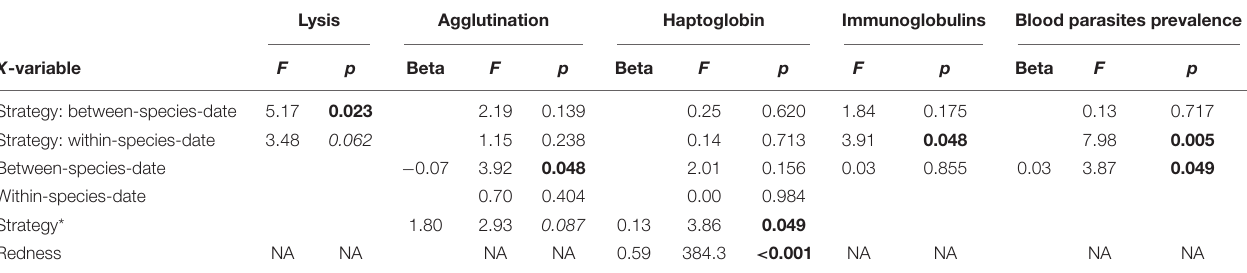
TABLE 1 | Statistics and coefficients for linear mixed models analysing immune function and blood parasite infections in migrating birds during autumn migration at Falsterbo, Sweden. Lysis Agglutination Haptoglobin Immunoglobulins Blood parasites